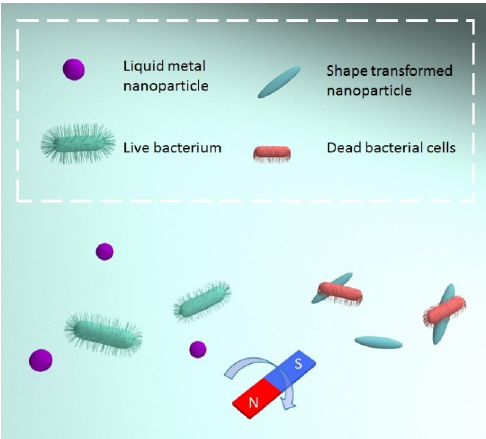
Figure 6. A schematic illustration of the actuated gallium-based liquid metal (GLM-Fe) particles. (A) Shape-transformation of the actuated GLM-Fe particles from spherical to high-aspect-ratio shapes when exposed to a rotating magnetic field.